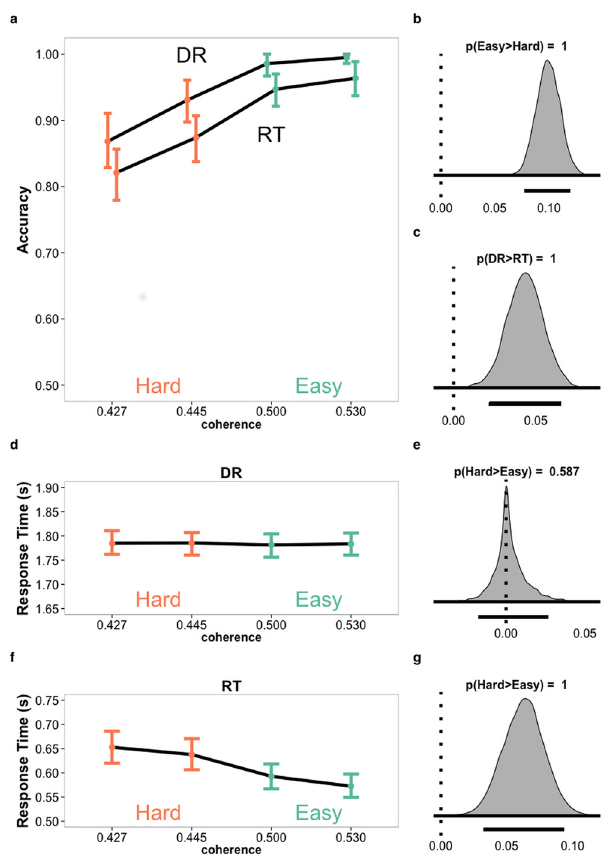
Fig 2. Posterior distributions of behavioral results. Estimated posterior distributions for accuracy (A) and response time in delayed response (DR) (D) and reaction time (RT) (F) conditions by coherence levels with error bars representing the 95% highest density intervals (HDI). Density plots for chains of difference in posterior distributions grouped to easy (green) and hard (orange) for accuracy (B) and response time in DR (E) and RT (G). Difference in combined chains of posterior distributions for accuracy in DR and RT (C). Line below density plots represent 95% HDI of chains of difference.